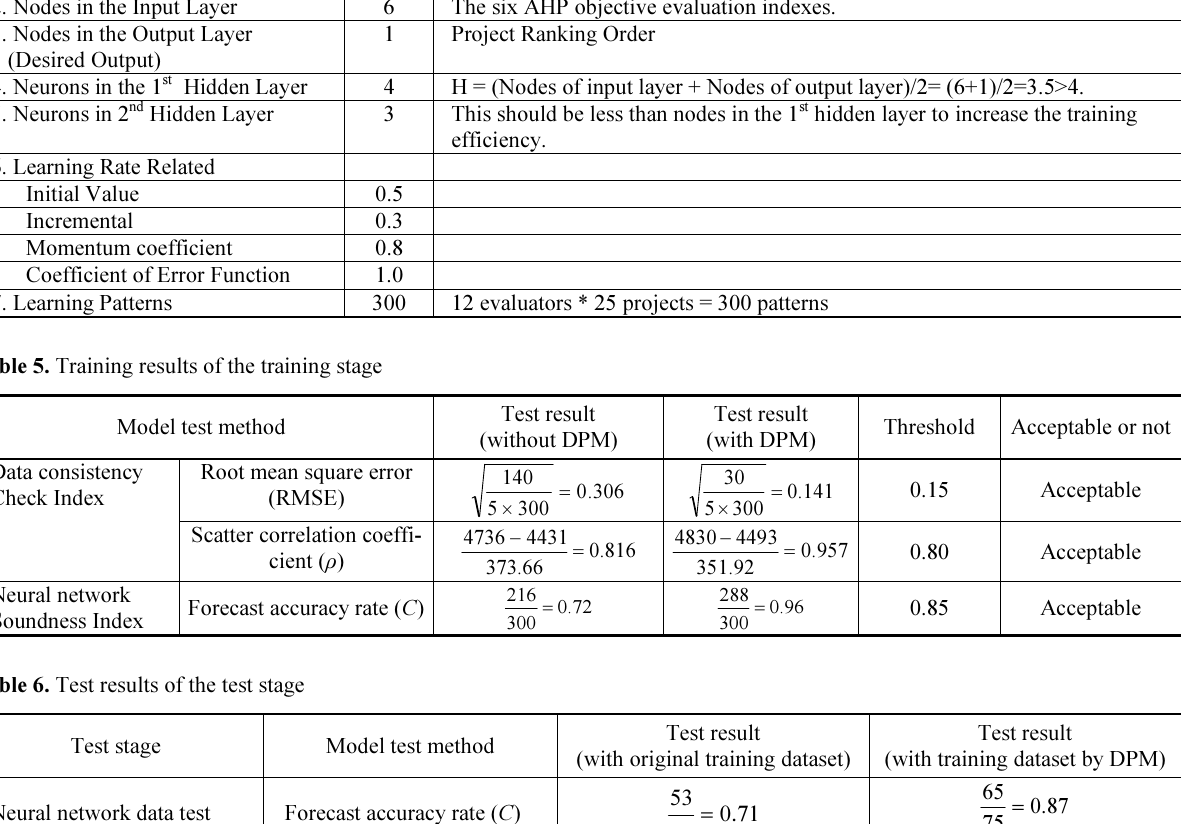
Table 4. Parameters for the error-back-propagation training algorithm Parameter Value Description